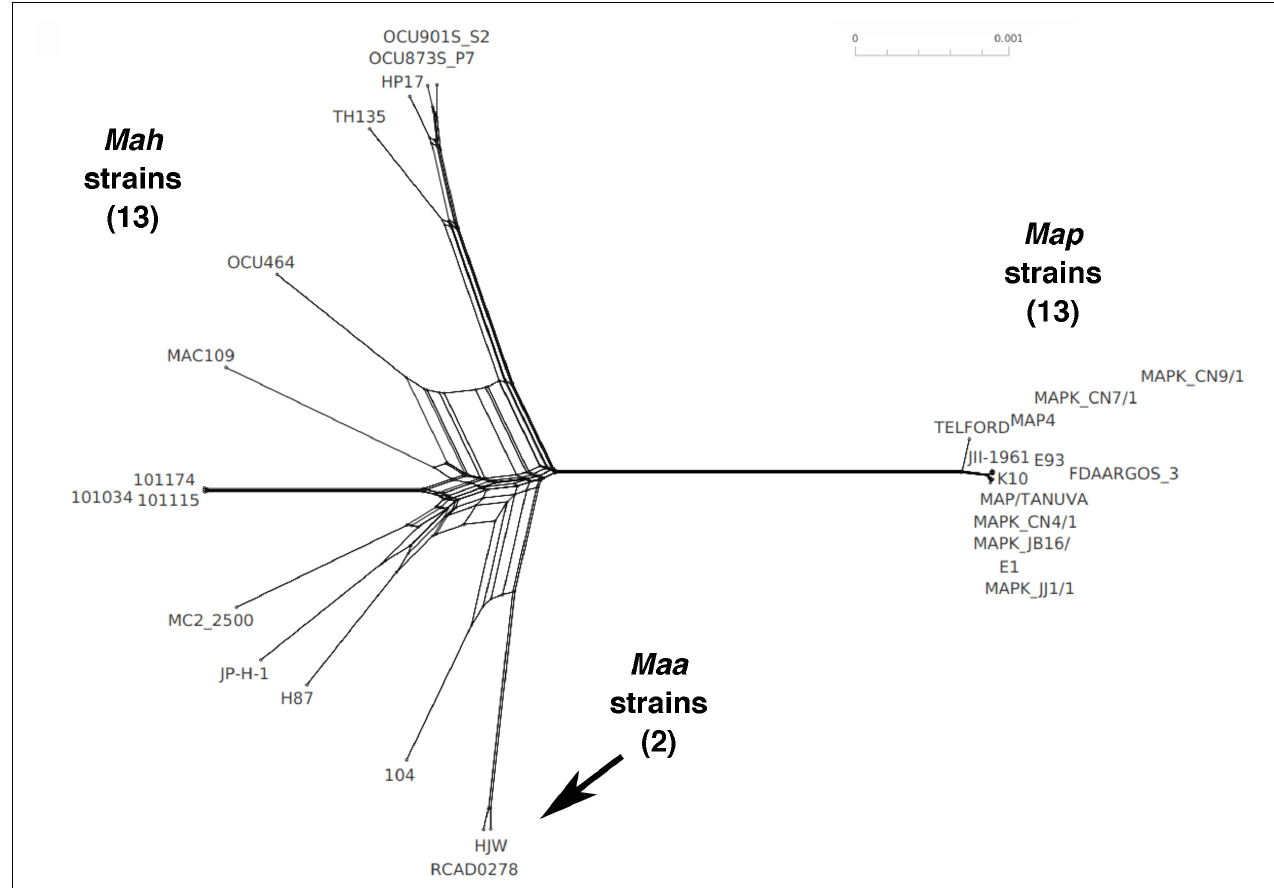
FIGURE 9 | Phylogenetic network of M. avium subspecies. Shown is a split network phylogeny of 28 M. avium strains based on Roary core gene alignment obtained by Neighbor-Net analysis in SplitsTree5. Note the tight clustering of the 13 Map strains and the 2 Maa strains in contrast to the broad range of the 13 Mah